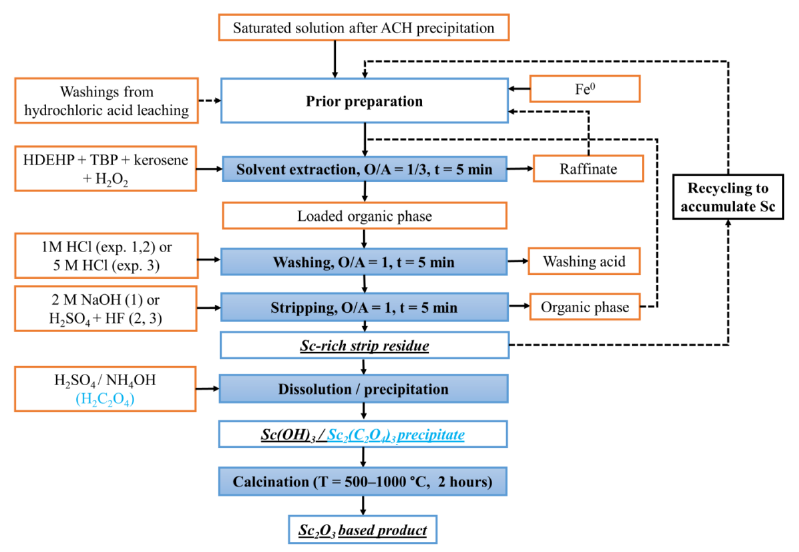
Figure 12. The flowsheet of the scandium recovery process after the precipitation of ACH from the mother liquor of high-pressure acid leaching of IDBR.